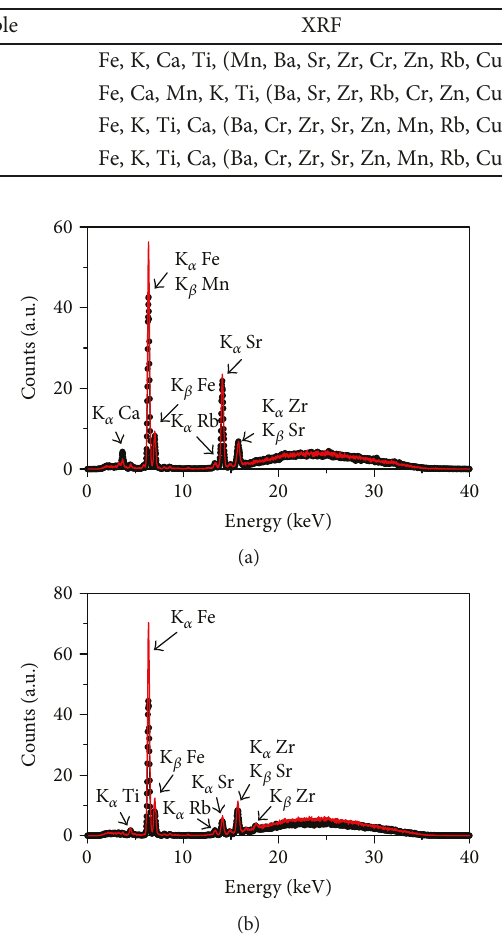
Figure 8: XRF spectra, in the 0 – 40 keV range, of SC2 (a) and SC4 (b) pottery fragments. Black circles refer to the back of each fragment, and red lines refer to its fi nishing